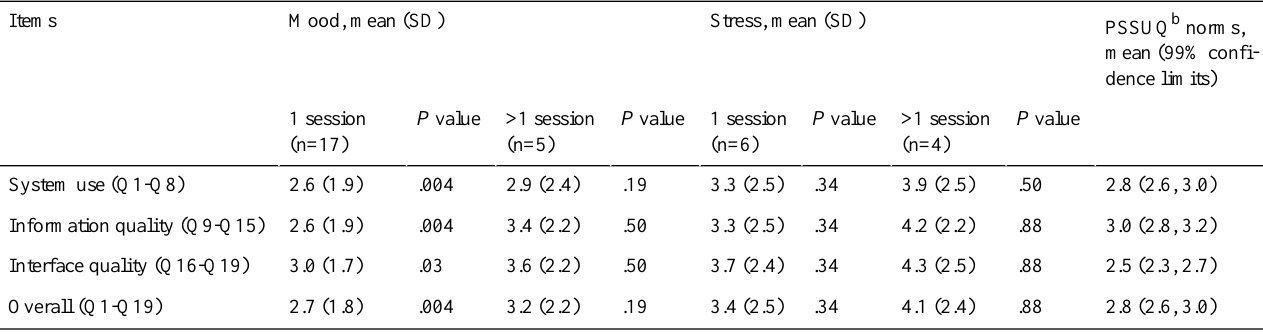
Table 3. PSSUQ scores for self-guided treatment of the mood (n=22) and stress (n=10) modules of individuals who completed one session versus those who completed multiple sessions.